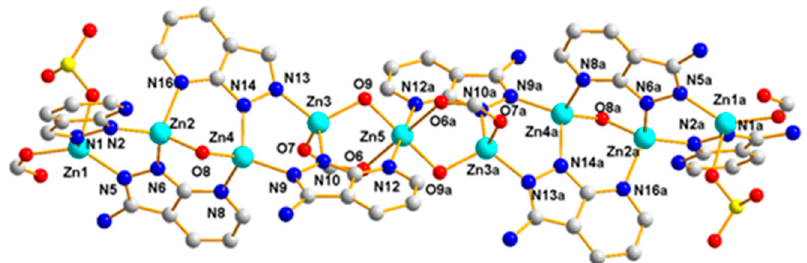
Figure 11. The {Zn 9 (L) 8 ( µ 2 -O) 3 (OCO) 2 } unit of Polymer 3.